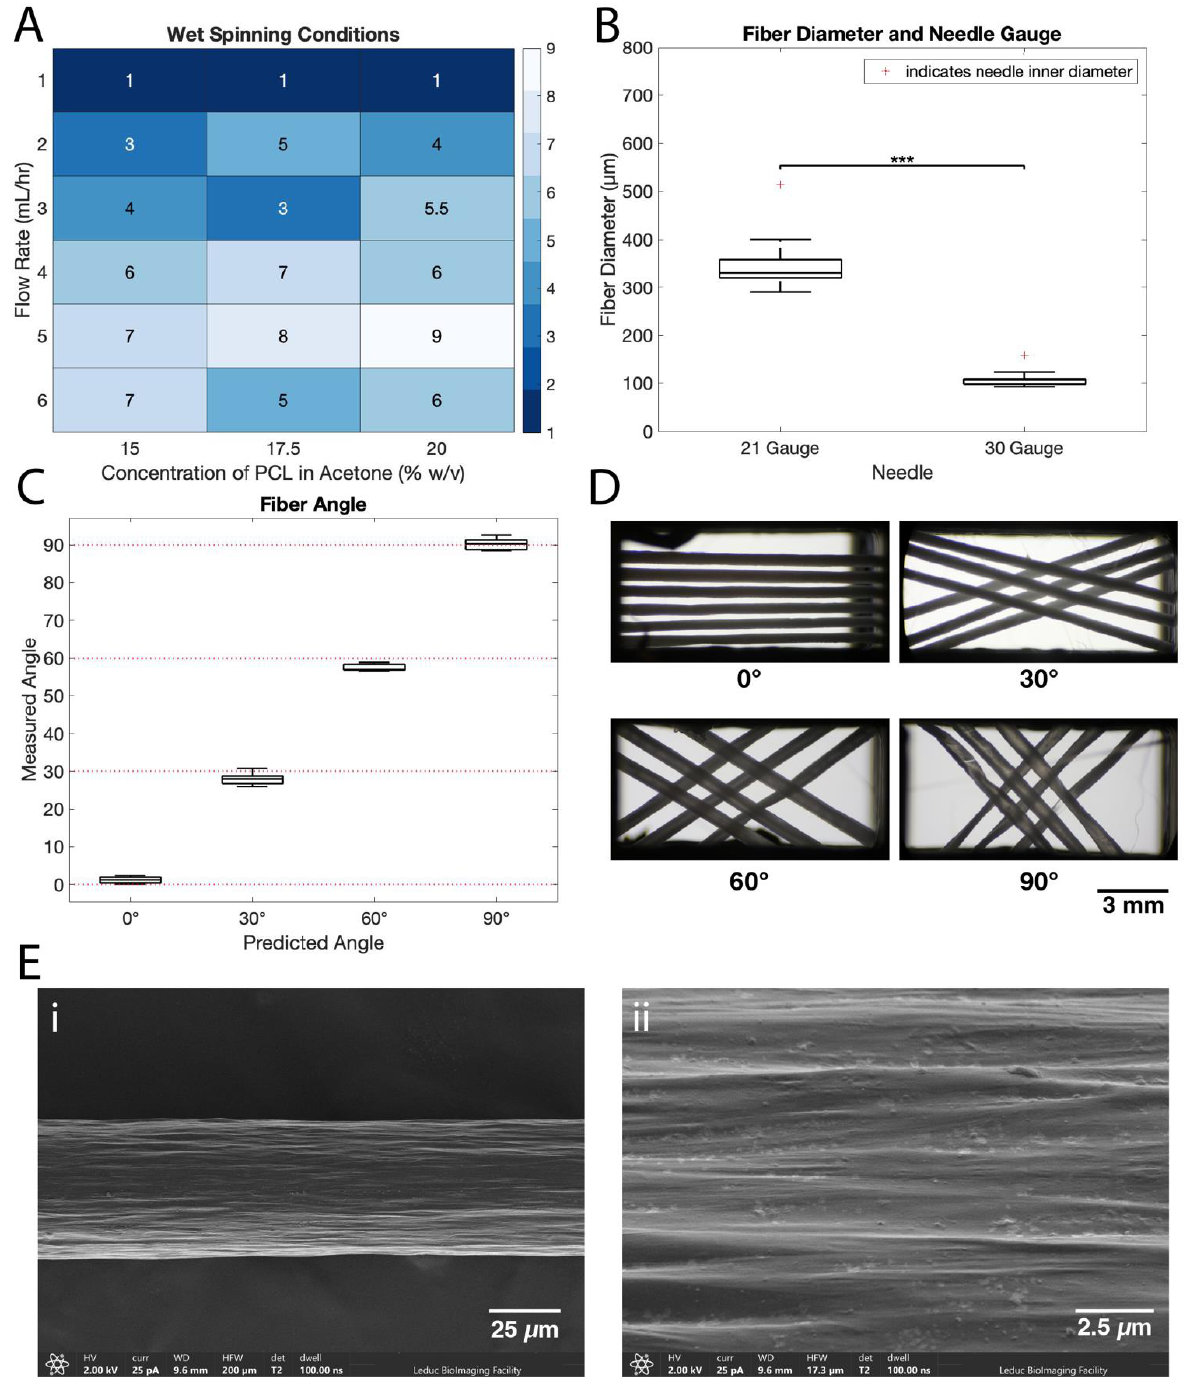
Figure 2. Optimized fiber and scaffold fabrication process produces consistent scaffolds with user- defined parameters. ( A ) Heatmap of fiber quality resulting from varying flow rate and PCL concen- trations. Ratings are given by operator observation, ranging from 1 (rough, uneven, poor quality) to 10 (smooth, uniform, excellent quality). ( B ) Boxplot of fiber diameters produced when utilizing two different needle sizes. Needle inner diameter is shown by the red crosses. (*** indicates p ≤ 0.001) ( C ) Measured angle and predicted angle between fibers for 0 ◦ , 30 ◦ , 60 ◦ , and 90 ◦ scaffolds from image analysis ( n = 5 scaffolds in each condition). ( D ) Representative images of scaffolds at 0 ◦ , 30 ◦ , 60 ◦ , and 90 ◦ fiber orientations. ( E ) SEM images of the surface of a single wet-spun PCL fiber at (i) low and (ii) high